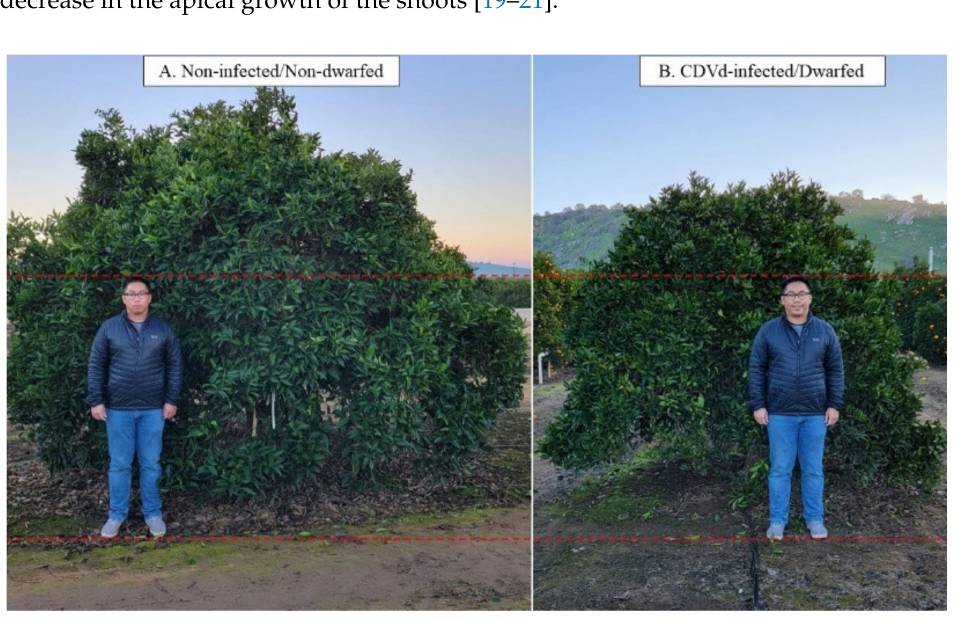
Figure 1. The observed dwarfing phenotype in navel orange ( Citrus sinensis (L.) Osbeck) on trifoliate ( Citrus trifoliata (L.) Raf.) rootstock. ( A ) is the non-infected/non-dwarfed tree and ( B ) is the citrus dwarfing viroid (CDVd)-infected/dwarfed